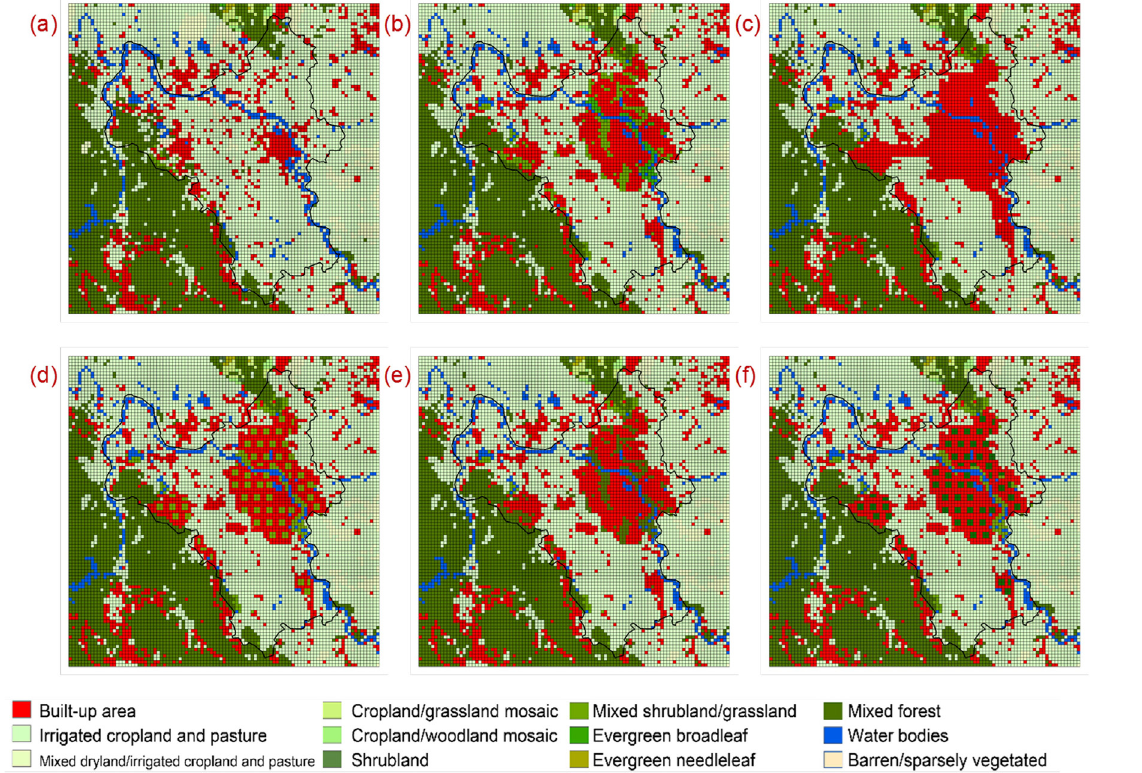
Figure 3. Land use land cover (LULC) of domain 4 for ( a ) the current condition (U_CUR); ( b ) the master plan scenario (U_HMP); ( c ) no green strategy scenario (U_NOGREEN); ( d ) equally distributed green spaces (U_PARK); ( e ) the master plan scenario with mixed